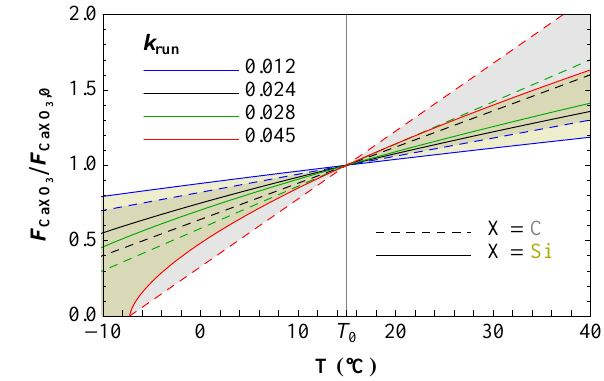
Fig. 9. Effects of changing run-off-temperature correlation constant ( k run , different colours) on carbonate (solid lines, green shading) and silicate (dashed lines, yellow shading) weathering-runoff feedbacks. Values for k run are taken from model output (0.024 - GENIE; 0.045 - NCAR CCM-3 (Berner and Kothavala, 2001)) and observational data (Fekete et al., 2002; New et al., 1999)(monthly time-series: 0.012 - global average; 0.028 - spatial on GENIE grid); see Sect. 3.3 for details and caveats. Note that lower values of k run give bigger fluxes for T < T 0